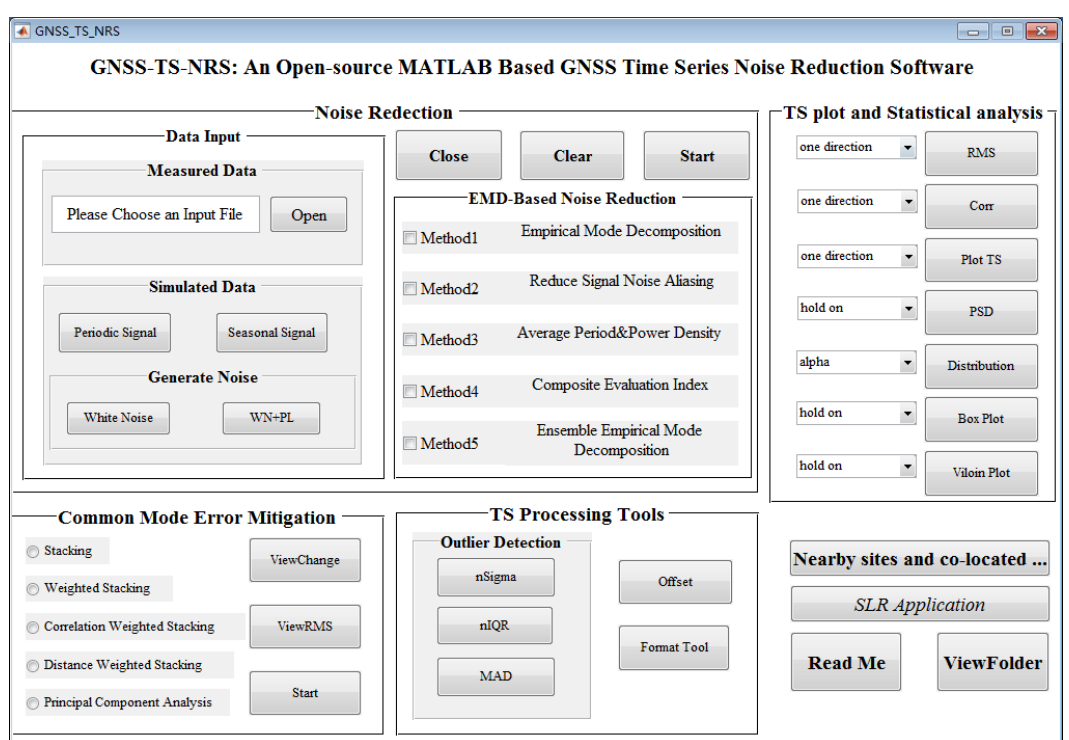
Figure 1. Main interface of global navigation satellite system time series noise reduction software (GNSS-TS-NRS).